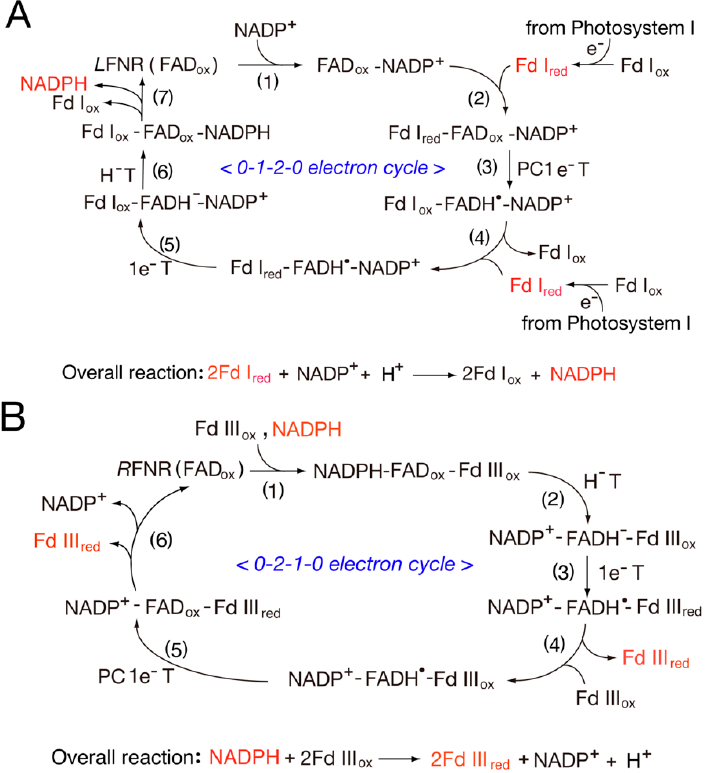
Figure 1. Proposed catalytic cycles of the L FNR ( A ) and R FNR ( B ) systems. ( A ) Photosystem I → L Fd I (2S-2Fe) → L FNR (FAD) → NADP + [45] and ( B ) NADPH → R FNR (FAD) → R Fd III → metabolic